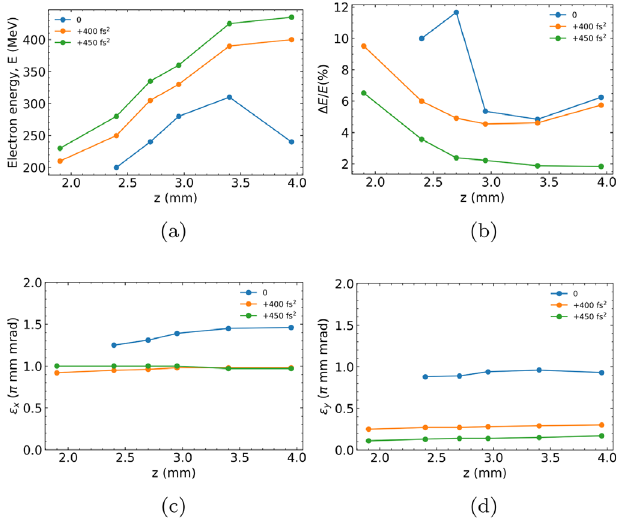
FIG. 4. Evolution of electron bunch properties over the longi- tudinal traveling distance z : (a) peak energy (E), (b) relative energy spread ( Δ E=E %), (c) normalized rms values of the emittance in the x , and (d) y directions. In each figure, three curves represents different values of group delay dispersion ( ϕ ð 2 Þ ) of the laser pulse.